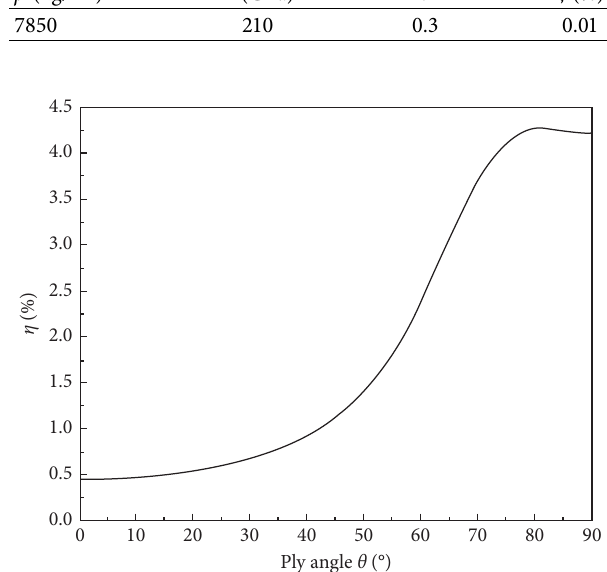
Figure 5: Variation of the modal loss factor with ply angle (l/ d � 10, σ �